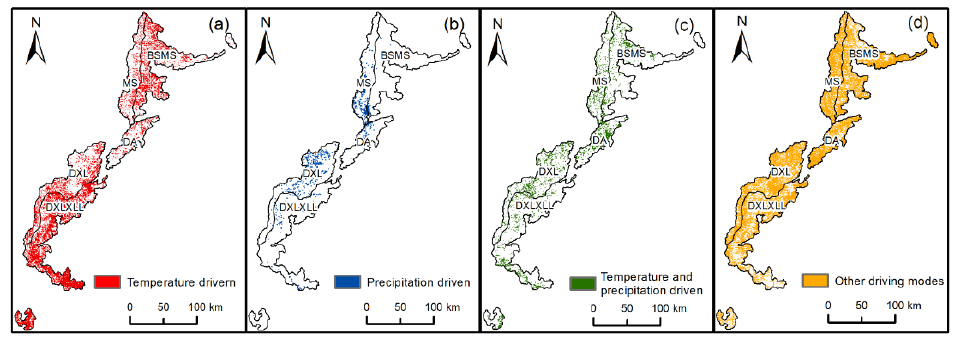
Figure 9. Climate-driven zoning map. ( a ) Temperature-driven; ( b ) precipitation-driven; ( c ) temperature- and precipitation-driven; ( d ) other driving